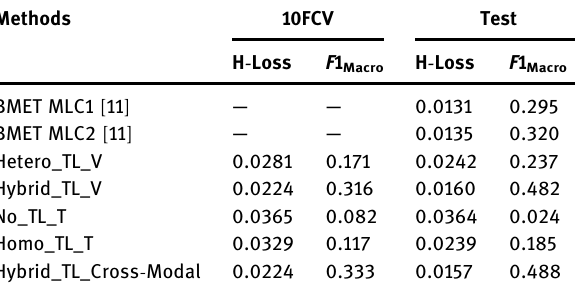
Table 2: Performance comparison of ImageCLEF2016 multi - label